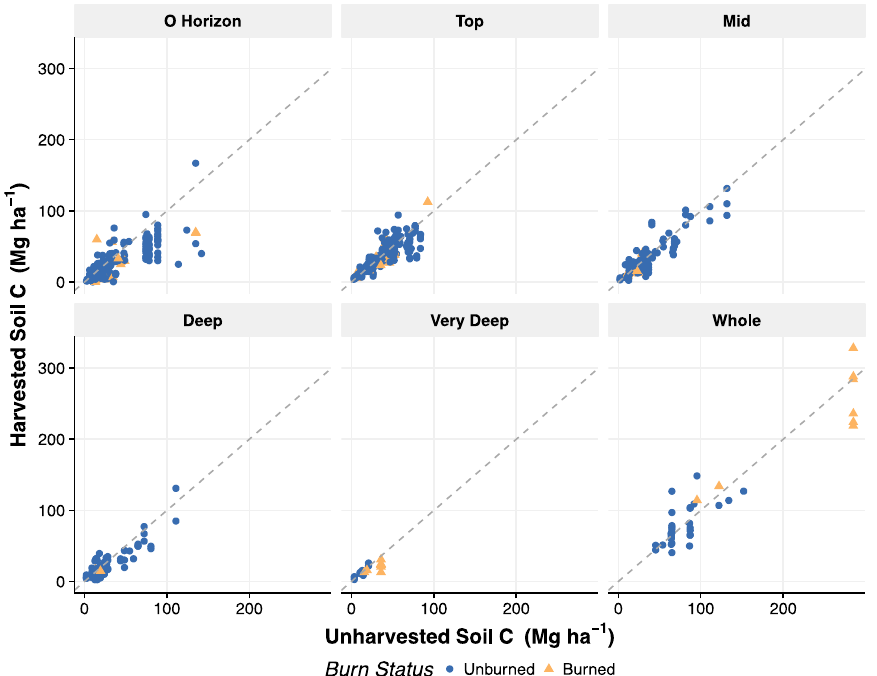
Figure 7. Absolute change in soil C due to harvest for each soil depth in this analysis (O horizon, top, mid, deep, very deep, and whole mineral soil). Different points show burned (yellow triangle) and unburned (blue circle) pretreatment strategies. Dashed 1:1 lines in each facet represent no response due to harvest. The total number of responses shown is k = 746.